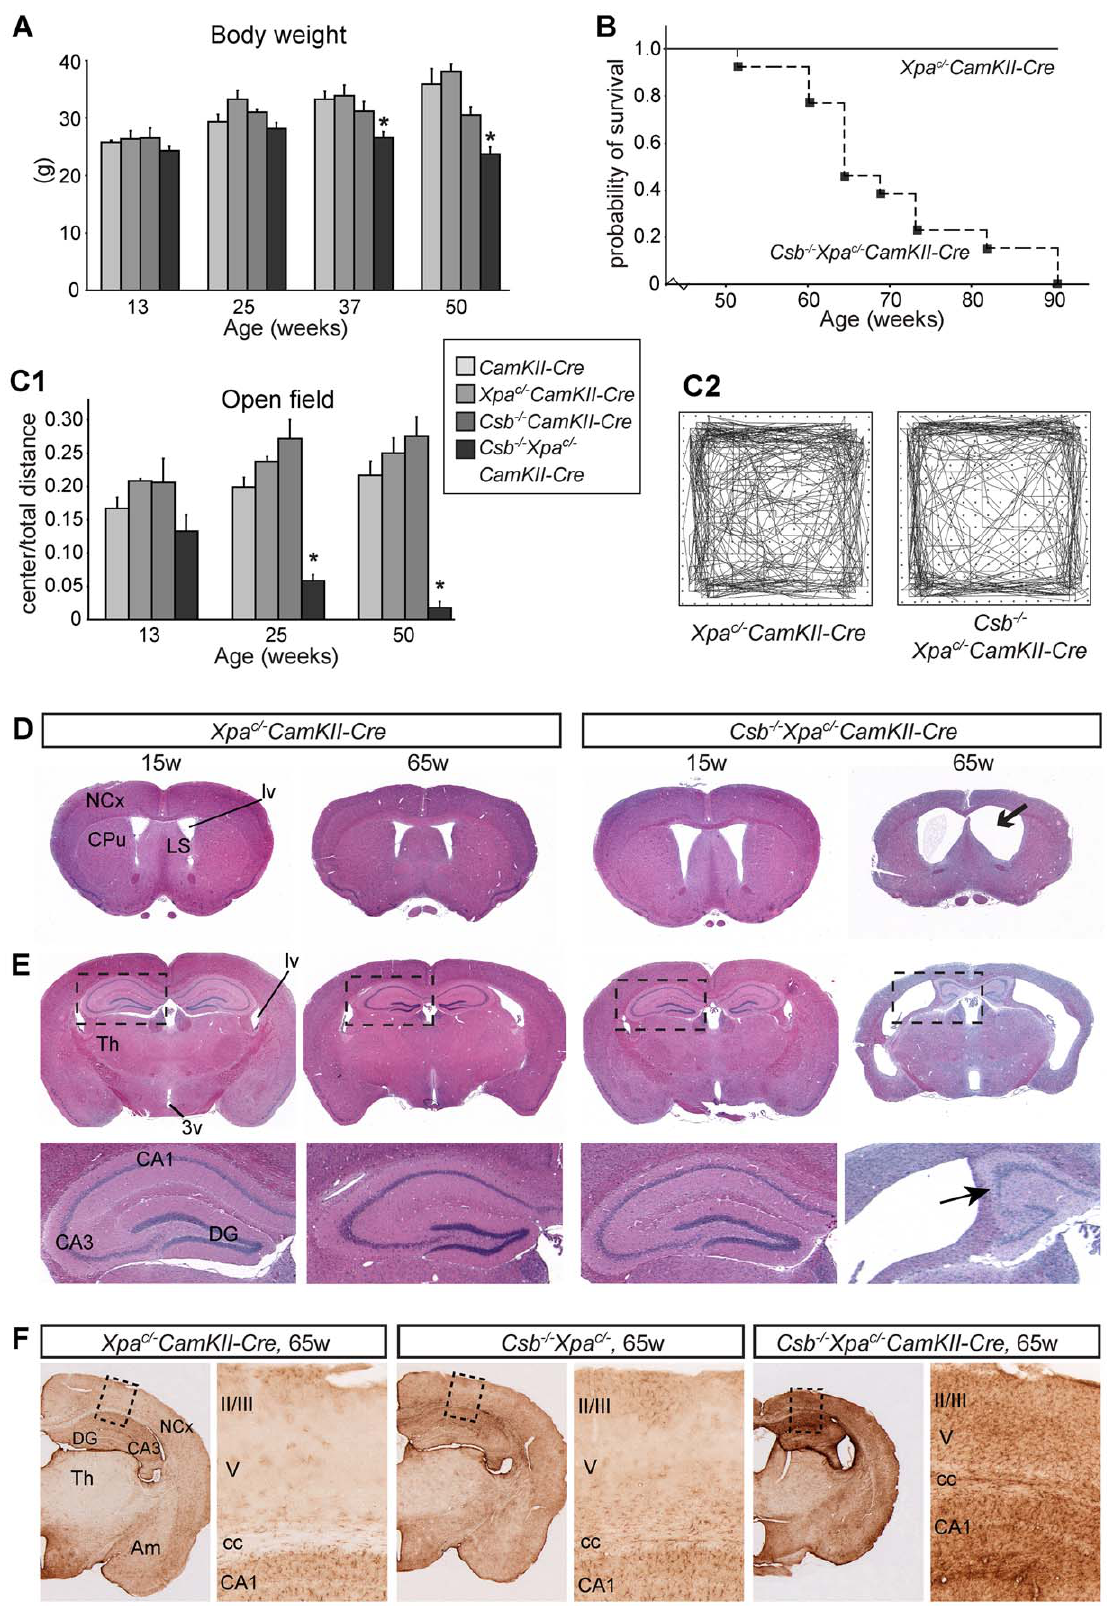
Figure 5. Reduced lifespan, age-dependent behavioral abnormalities, and brain atrophy in forebrain neuron-specific knockout of Xpa in Csb 2 / 2 mice. A) Mean body weight of CamKII a -Cre , Csb 2 / 2 CamKII a -Cre , Xpa c/ 2 CamKII a -Cre and Csb 2 / 2 / Xpa c/ 2 / CamKII a -Cre mice. Values are